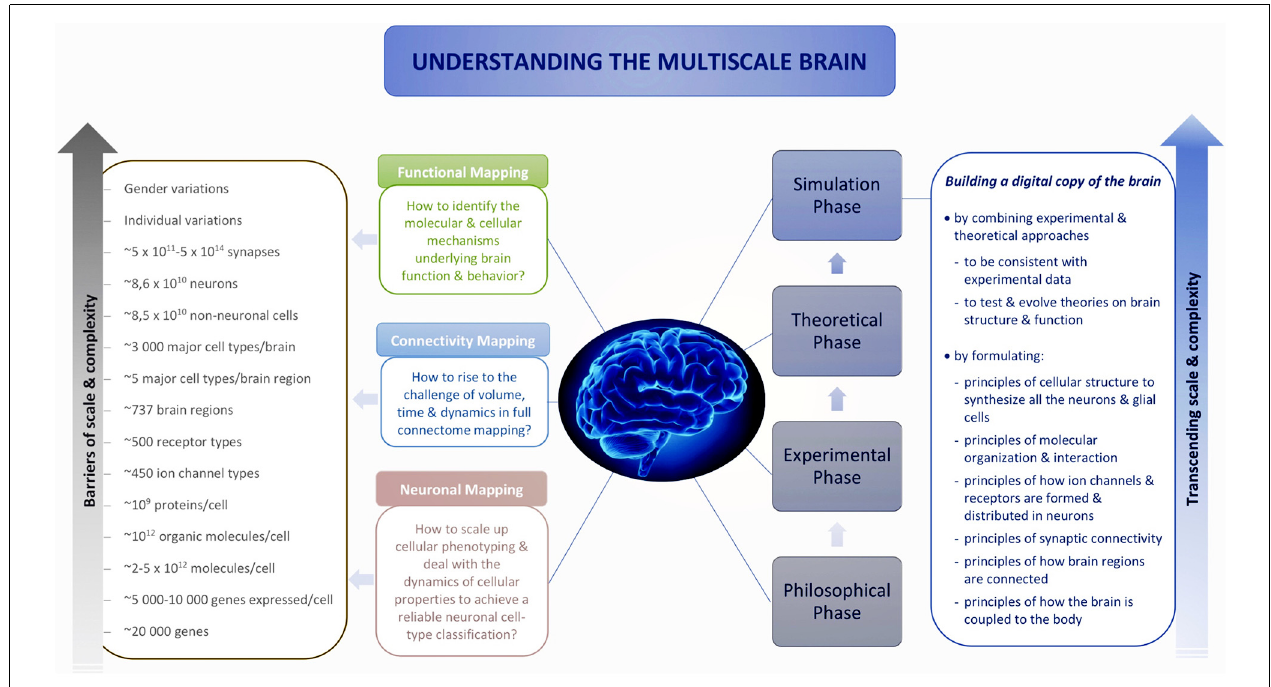
FIGURE 1 | Understanding the multiscale